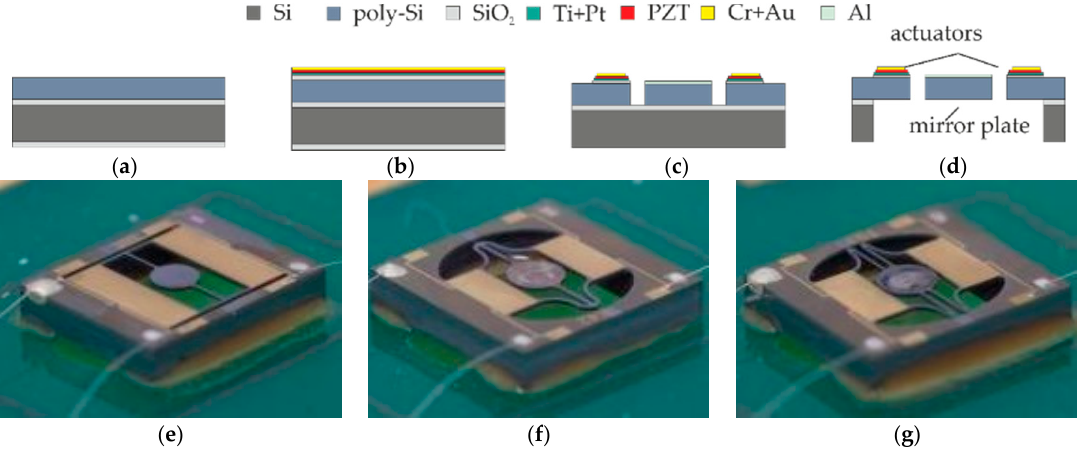
Figure 6. Cross-sectional process flow and device photos: ( a ) Substrate made of poly-Si, SiO 2 and Si layer; ( b ) Deposition of functional layers; ( c ) Structuring by wet and dry etching from the front side; ( d ) Release by dry etching from the rear side; ( e ) Device photo of design S1; ( f ) Device photo of design E4; ( g ) Device photo of design E5.